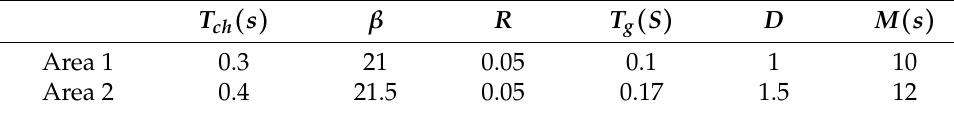
Table 1. LFC systems parameters with T 12 = 0.1986 pu/rad.